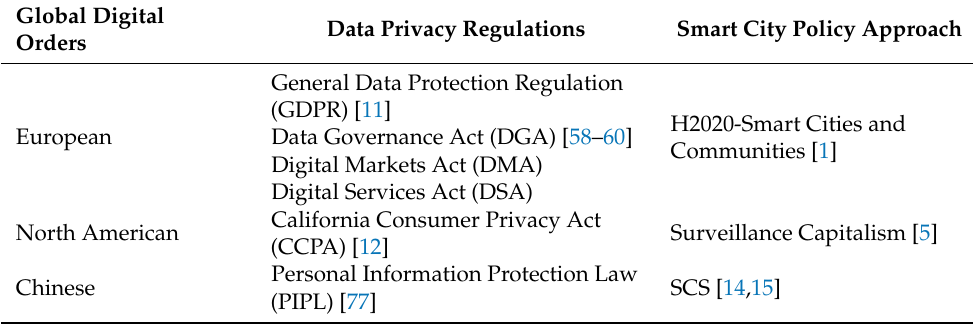
Table 1. Depicting three data privacy regulations in the global digital order: GDPR, CCPA, and